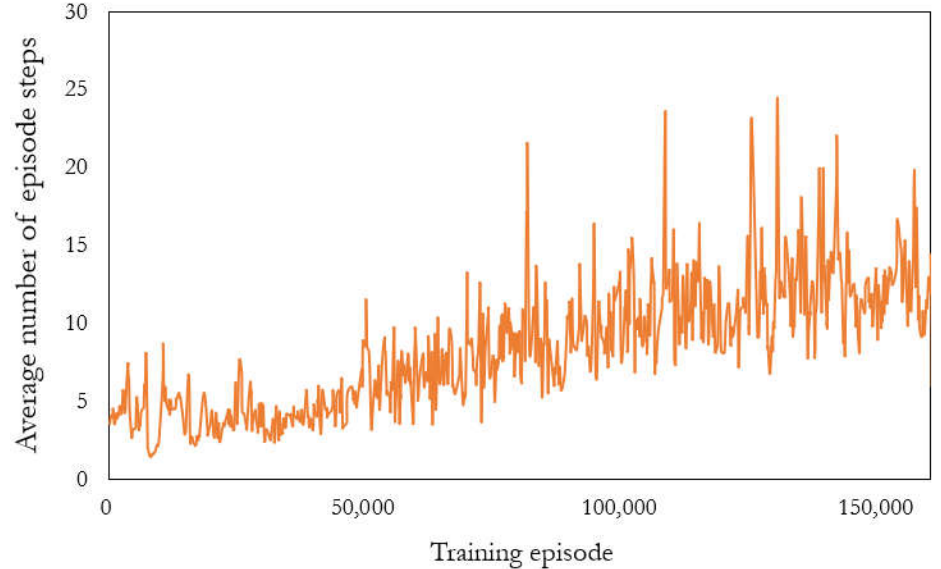
Figure 5. Average number of steps for last 100 training episodes for discount factor = 0.1.